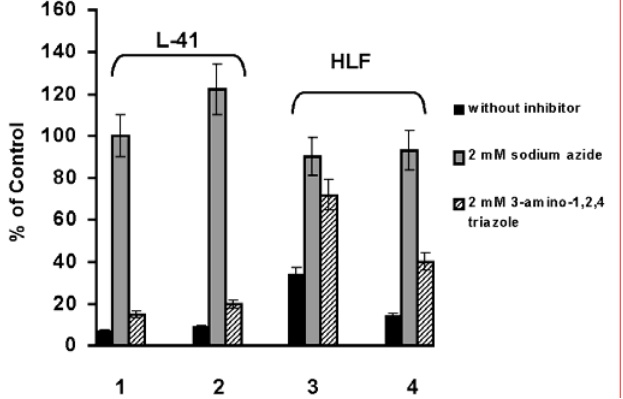
FIGURE 4. Effects of NaN 3 and 3-AT inhibitory action on the antioxidant capacity of cell crude extracts estimated by ESR method. ·OH-radical level in the model Fenton reaction is assigned as 100%. ESR measurements were conducted in 120 sec after preparation of the mixture; (1) and (3) are 1 × 0.168 mg/ml of protein in the ESR sample; (2) and (4) are 2 × 0.168 mg/ml of protein in the ESR sample. The data presented are mean values ± S.D. from three separate sets of